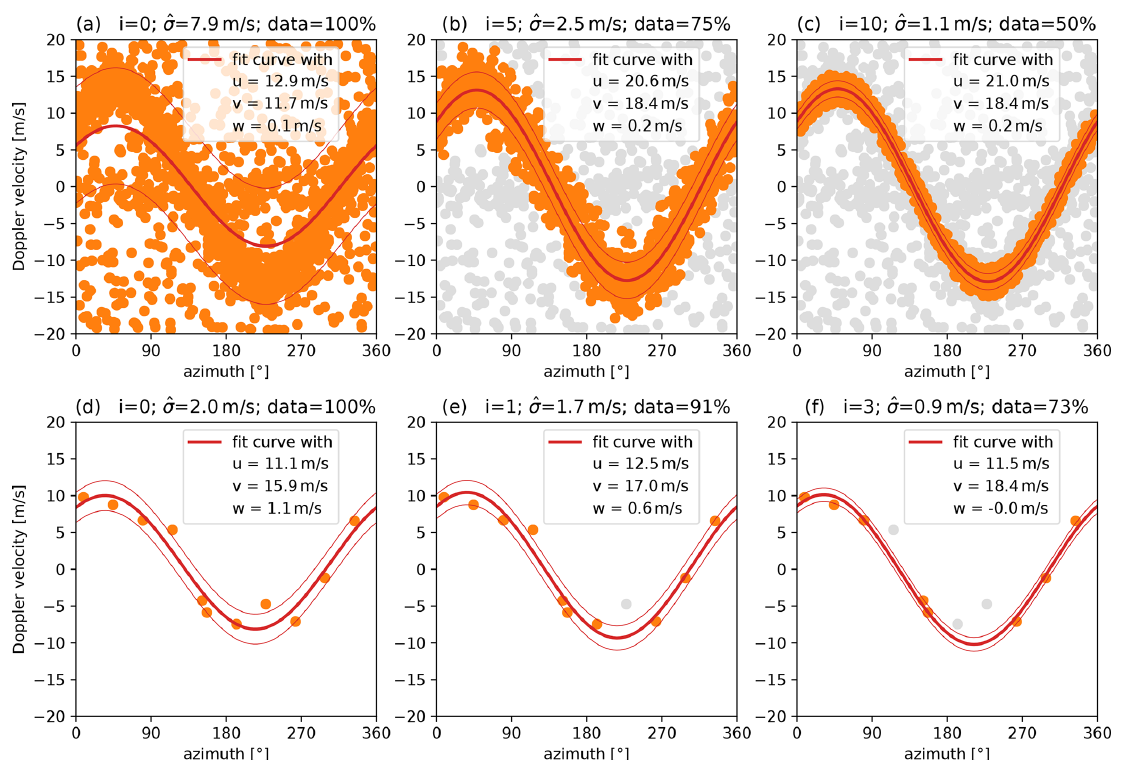
Figure 6. Different steps (i) of the retrieval for 10min mean wind (a–c) and for the wind of a single DWL cycle (d–f) . The sinusoidal projection (fit curve with) of the fitted wind vector ( u , v , and w ) is shown in thick red, with a standard deviation tube around it ( ±ˆ σ , red). Observations used for the displayed wind vector fit are orange, and omitted observations are grey. Panels (c) and (f) display the fits that are finally returned. The examples are from a DWL operated in CSM2 on 10 February 2020 and from measurements at 808m (a–c) and 225m (d–f)